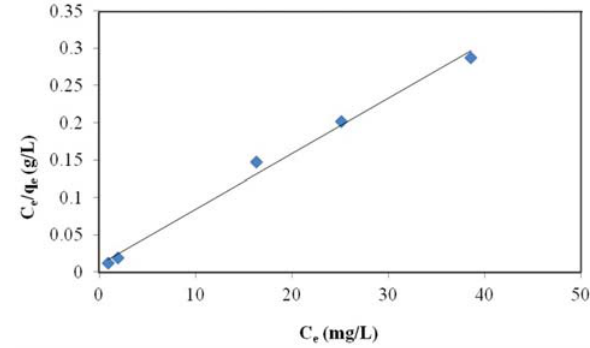
Figure 6. Langmuir isotherm on adsorption of MB by NTA-BP (Condition: 0.02 g of adsorbent in 20 mL of 100, 125, 150, 175, 200 mg/L MB dye solution at 150 rpm for 6 hours).